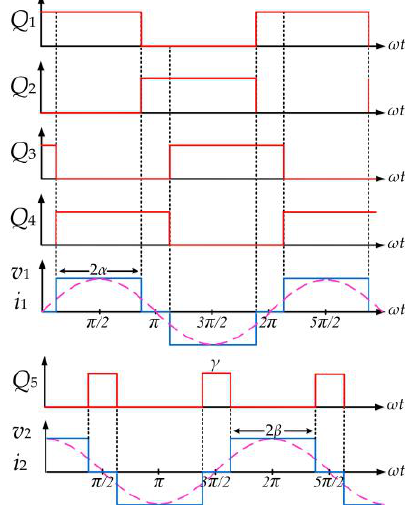
Figure 2. Typical waveforms of transmitter and receiver.